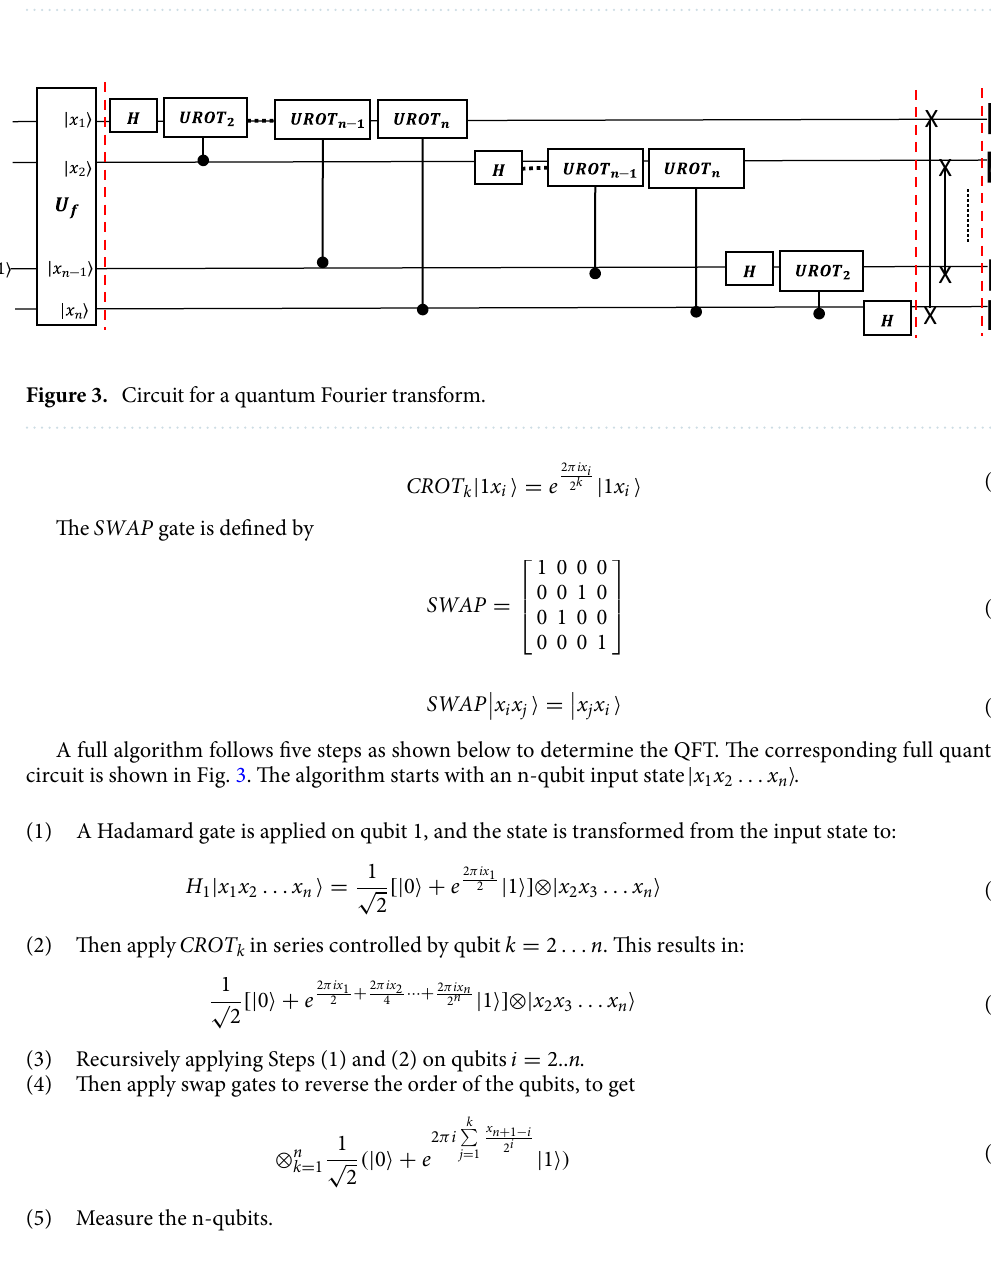
Figure 2. Quantum gates.